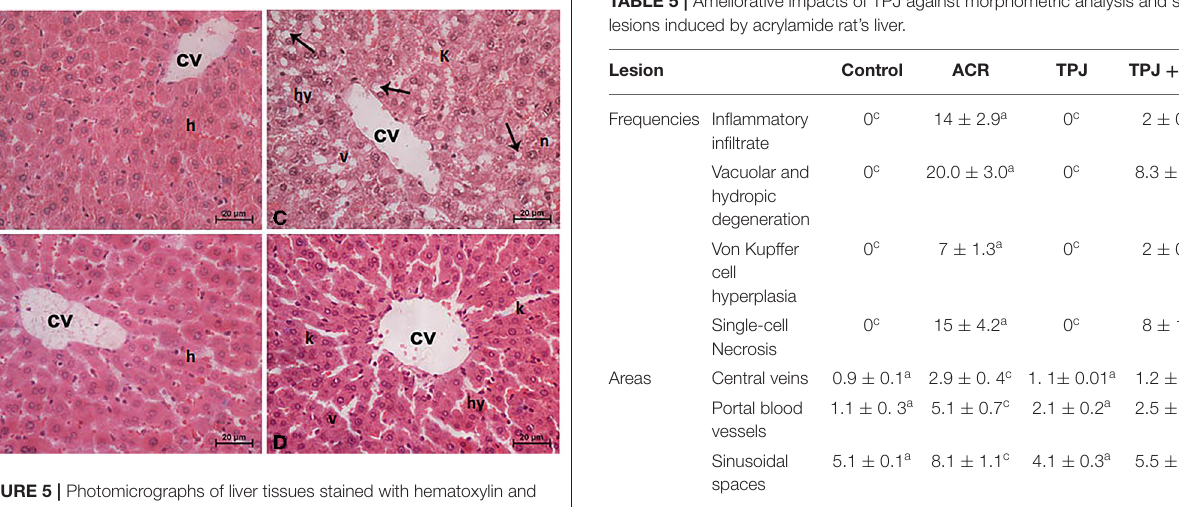
gene to a comparable level (1.05-fold) to the control group